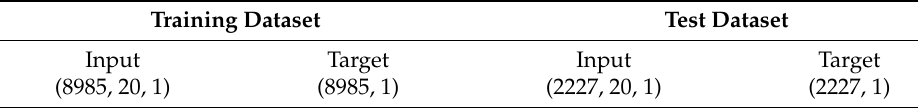
Figure 4. Preprocessed power consumption data. Table 4. Configuring the dataset used for training.